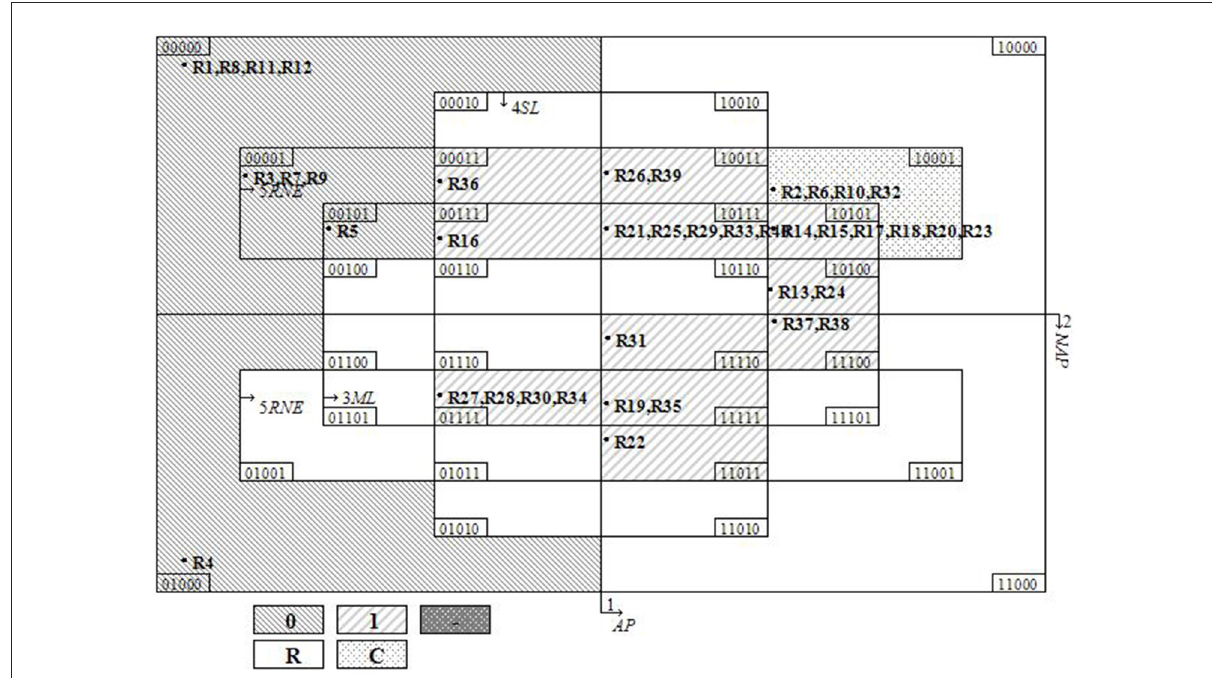
FIGURE2 Visualization of truth tables under median thresholds. Data source: The result of this figure is reported by the Visualize function of Tosmana. “0” means that the result does not occur, “1” means that the result occurs, “R” means Logical remainders, and “C” means Contradictory solution.